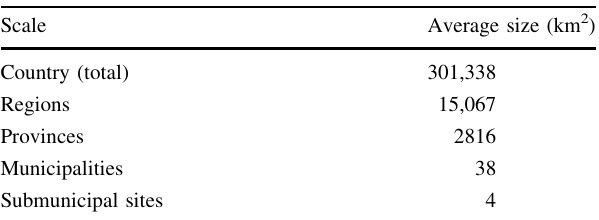
Table 1 Aggregation scale for elements at risk on the #italiasicura